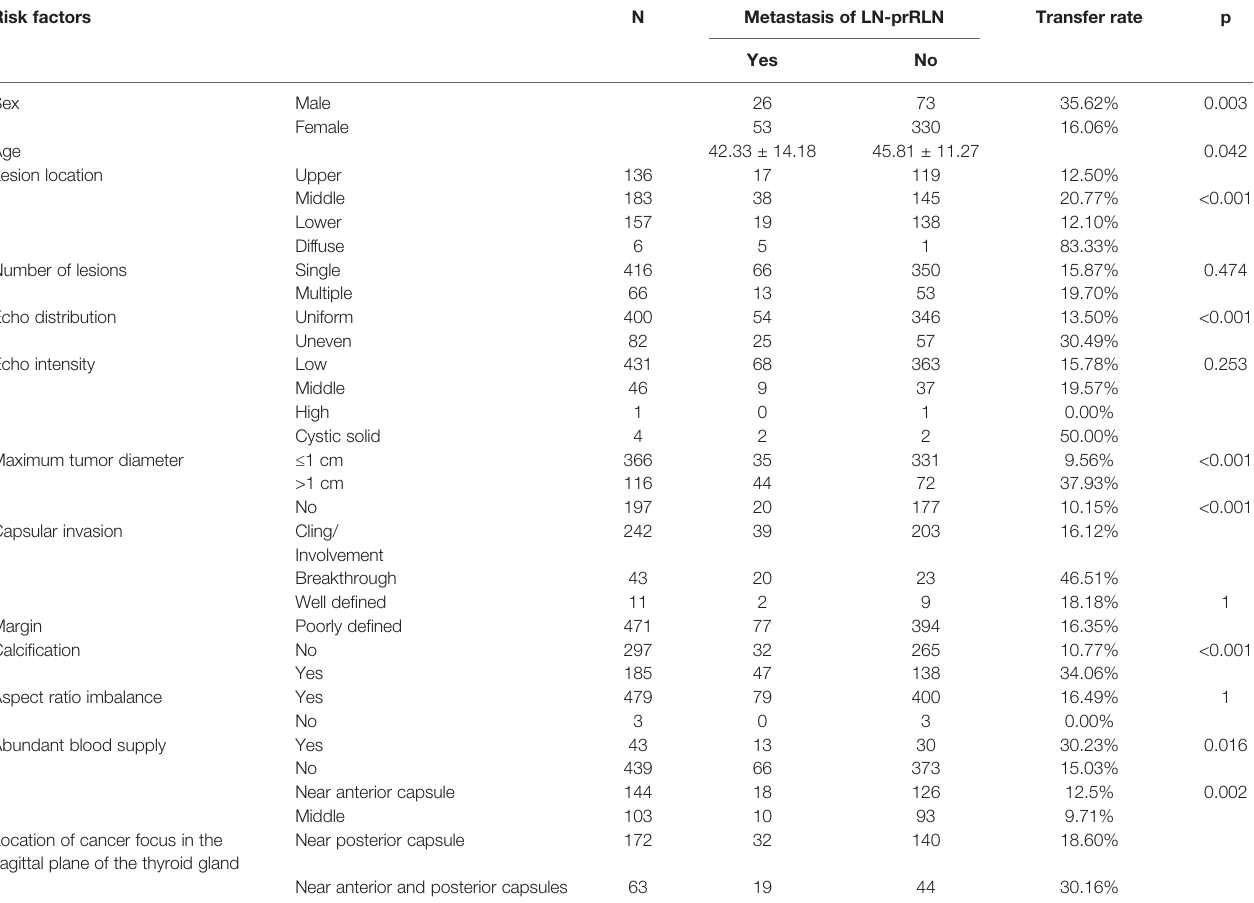
TABLE 1 | Single-factor analysis of preoperative ultrasound features of PTC and LN-prRLN metastasis. Risk factors